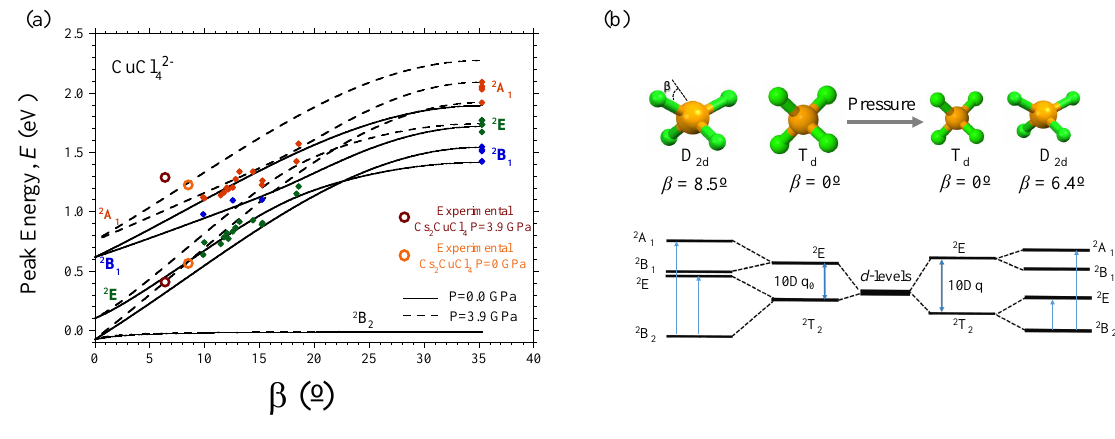
Figure 4: (a) Calculated crystal-field energies for CuCl 2 − as a function of the distortion angle ( β ) using AOM. 4 β = 0 ◦ corresponds to T d (regular tetrahedron), and β = 32 . 5 ◦ to D 4 h CuCl 2 − (square-planar). Solid and dashed 4 lines correspond to calculations at ambient pressure and 3.9 GPa, respectively. The spin-orbit coupling have been included in the calculations with λ = -829 cm − 1 (see text for details). Filled color symbols correspond to experimental data from the compound series providing different Cl–Cu–Cl bond angles for CuCl 2 − [15,17]. 4 Empty circles correspond to present experimental data for Cs 2 CuCl 4 at ambient pressure (orange) and 3.9 GPa (dark red). Note that the trends of the variation is in agreement with structural data obtained by XRD [4]. (b) Schematic diagram of the Cu 2+ d -orbital splitting in D 2 d and T d symmetry for four different configurations corresponding to ambient pressure (left) and high-pressure conditions (3.9 GPa, right). In T d only R is changed whereas both R and β are modified in D 2 d